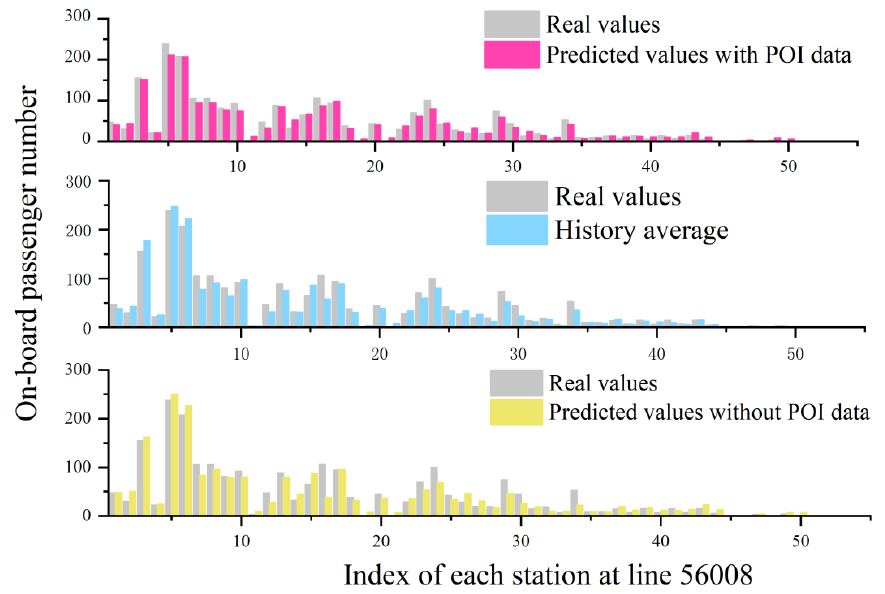
Figure 8. Predicted and true values of on-board passenger numbers using three models.